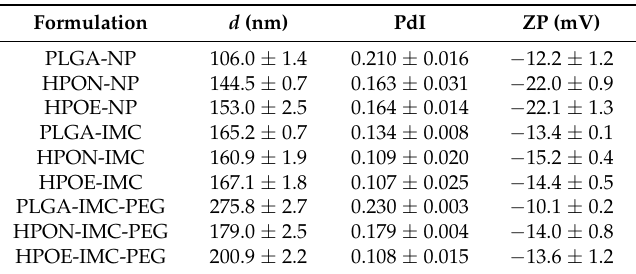
Table 3. Hydrodynamic features of analyzed